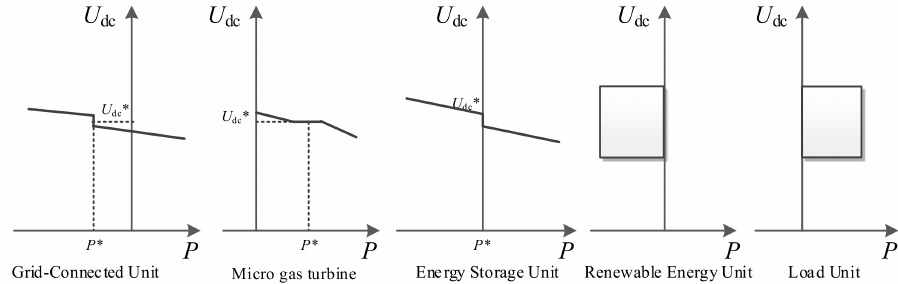
Figure 8. Coordinated control design between devices in the DC